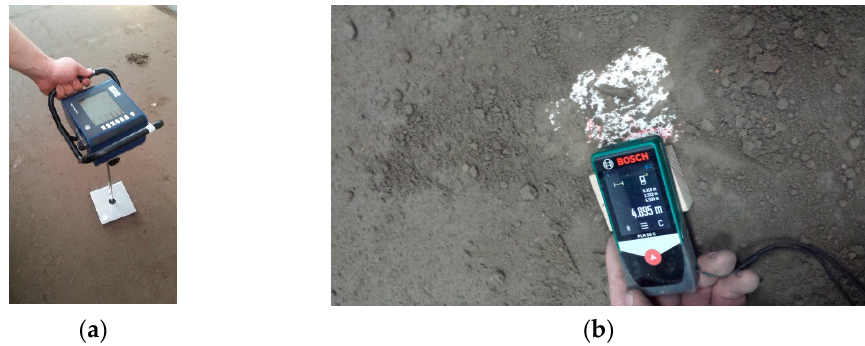
Figure 5. Procedure for placing stones: ( a ) planned grid for the placement of stones, ( b ) preparing a hole in the shape of a stone and placing the stones in the soil, ( c ) compaction of soil with stones.